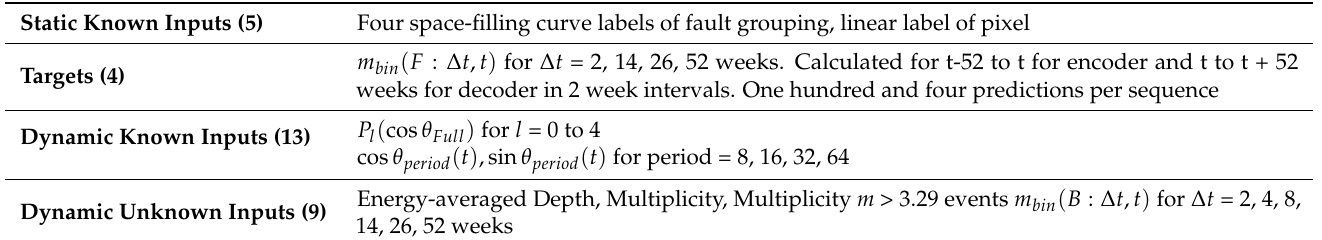
Table 5. Input and output variables for the modified temporal fusion